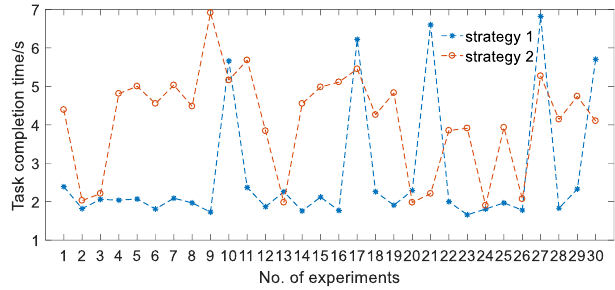
Figure 8. Task processing time under strategy 1 and strategy 2.